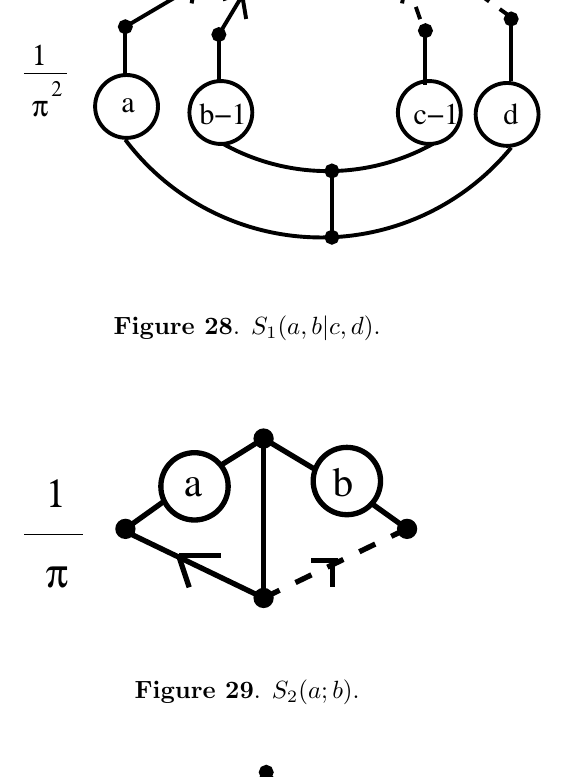
Figure 29 . S 2 ( a ; b ).